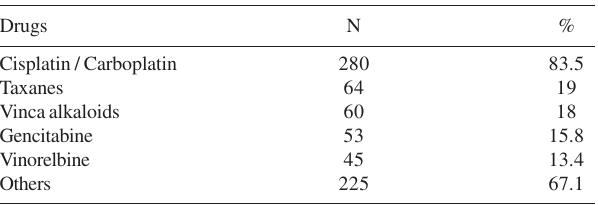
Table 3 – Drugs used in different regimens of chemotherapy.